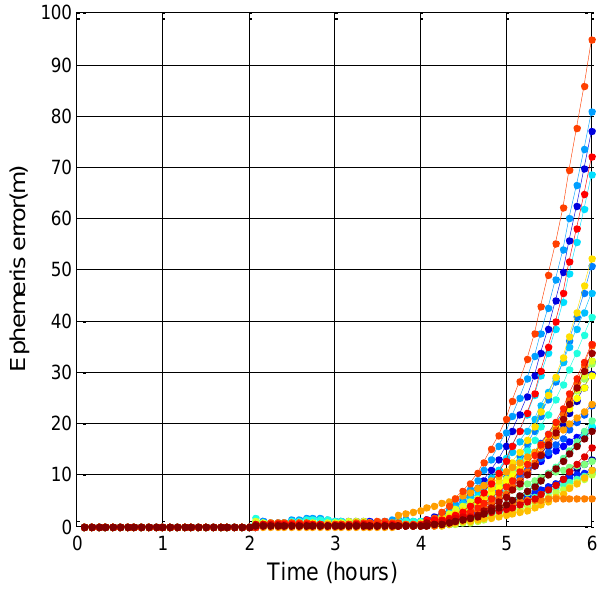
Figure 11. GPS DQA3: The same ephemeris used for 6 h.